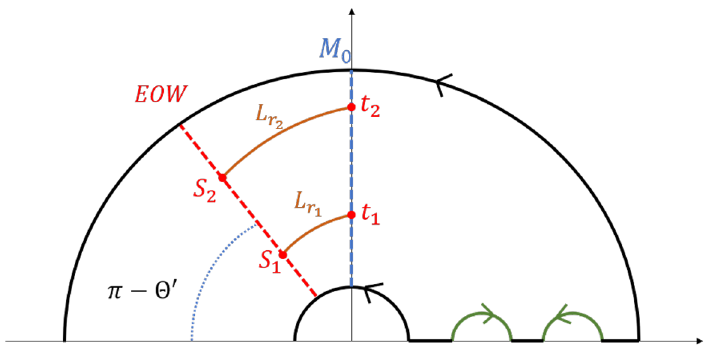
Figure 27 . The covering space construction of the real geometry part (white region) in figure 11 is depicted here. The length of the blue vertical line matches that of M 0 in figure